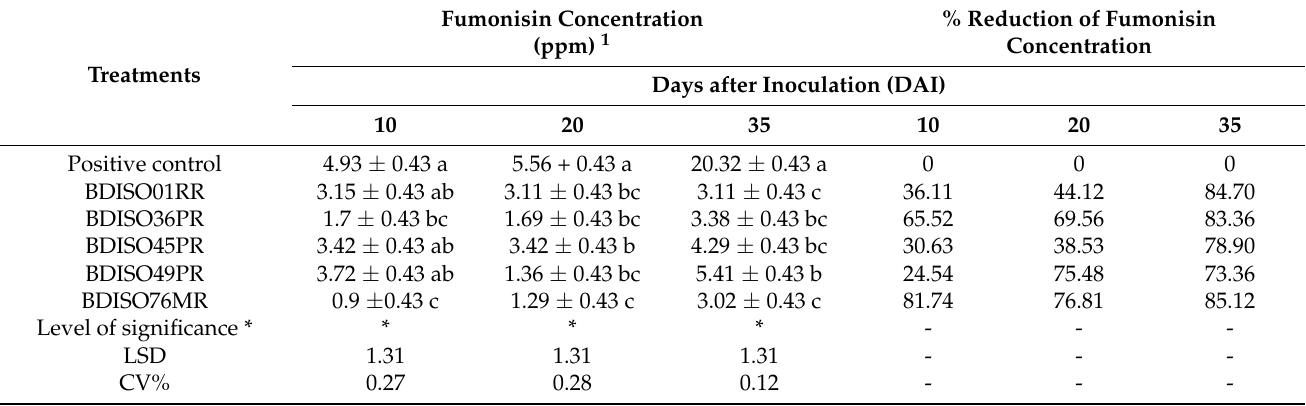
Table 2. Effect of Bacillus species on the reduction of fumonisin accumulation in co-inoculated maize grains.